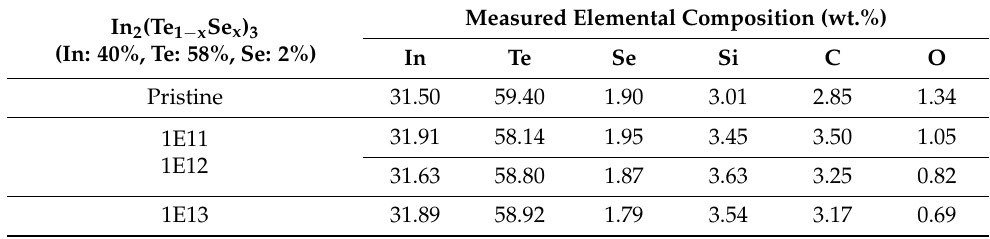
Figure 3. FESEM images of In 2 (Te 0.98 Se 0.02 ) 3 films ( a ) pristine, ( b ) 1E11, ( c ) 1E12, and ( d ) 1E13. Table 2. Elemental compositions of In 2 (Te 0.98 Se 0.02 ) 3 thin